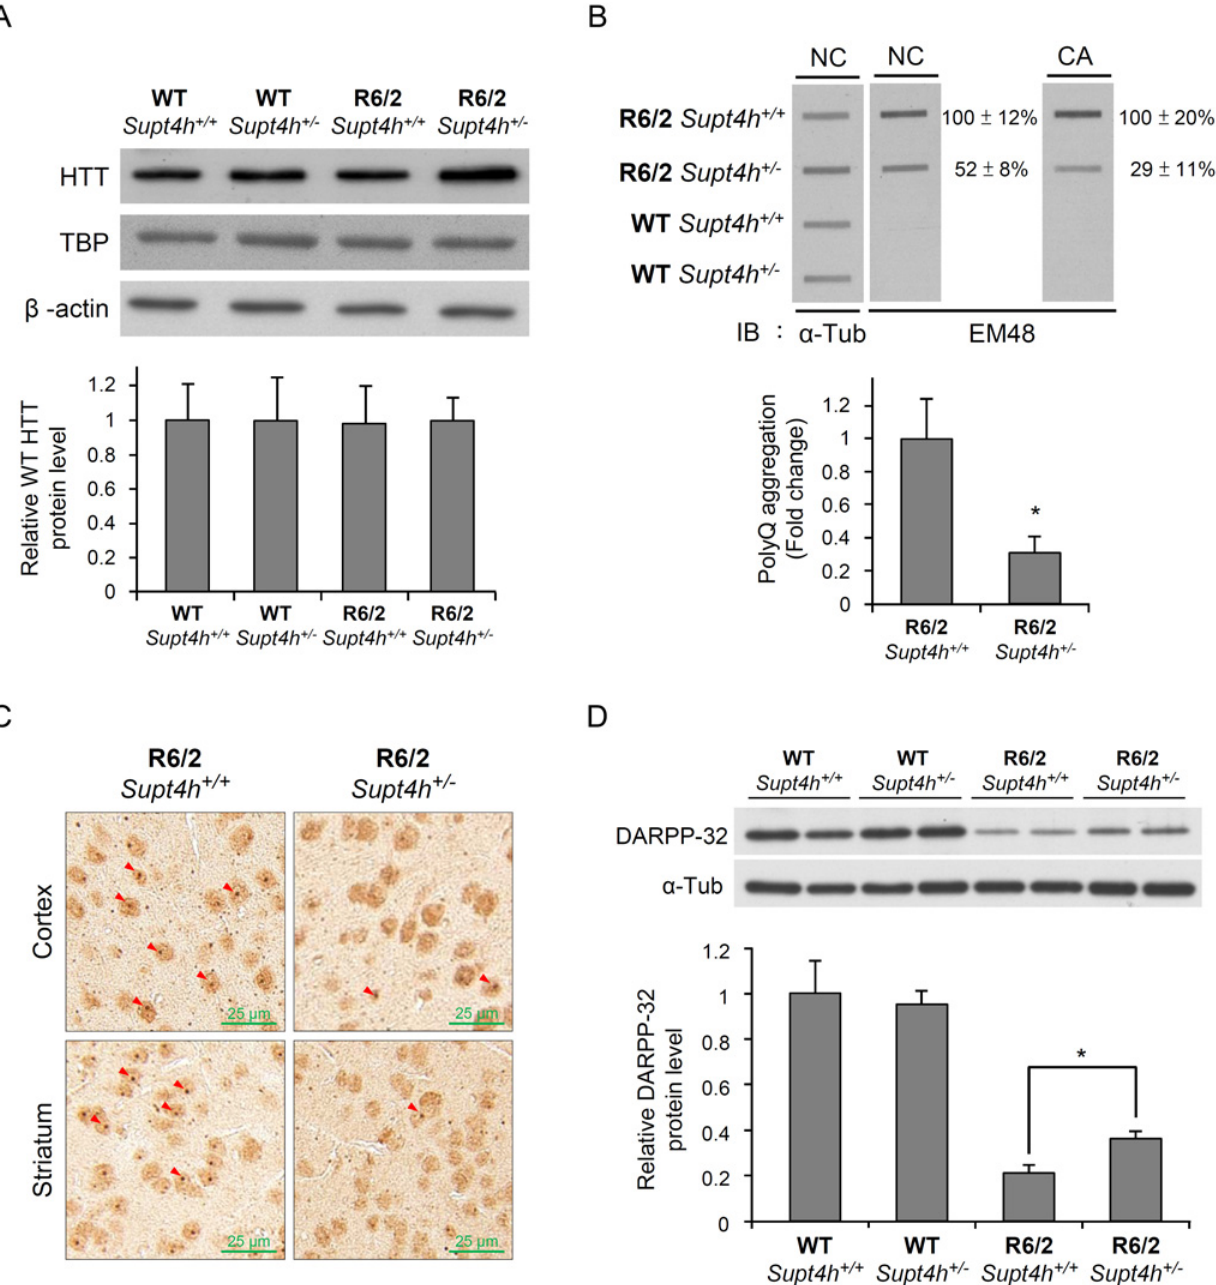
Fig 4. Mutant HTT aggregation in the brain of R6/2 mice deleted for one Supt4h allele. (A) Wild-type HTT protein levels were examined by Western blot analysis using brain lysates collected from right cerebrum of animals as described in Materials and Methods and in Fig 3B. TATA-binding protein (TBP) produced by a gene containing 13 – 15 consecutive CAA/CAG repeats was also analyzed. β -actin served as loading control. (B) Brain lysates collected from 12-week-old mice were loaded onto a cellulose acetate CA membrane, which traps only aggregated protein. Mutant HTT protein was detected using EM48 antibody. Nitrocellulose (NC) membranes were employed for slot blot assays to determine protein abundance; α -Tubulin served as a loading control. The values shown are means ± SEM, and the relative protein aggregation in tissues of R6/2 HD mice having two or one allele of Supt4h is presented in the bottom panel. (C) Representative IHC images of cerebral tissue of 12-week-old R6/2 (HD) mice having either one or two alleles of Supt4h are shown. HTT aggregates were detected using an antibody against ubiquitin, which is recruited to and co-localized with aggregates in the brain of HD mice [54]. The positions of aggregates are indicated by arrowheads. (D) DARPP-32 protein abundance was analyzed by Western blot analysis using brain lysates collected from R6/2 mice at the age of 12 weeks either intact in the Supt4h locus or deleted for one Supt4h allele. The level of WT mice having two Supt4h alleles was set to 1, after normalization with α -Tubulin. Data are presented as the mean ± SEM (n = 3 in each group; * , p < 0.05 by Student ’ s t -test).